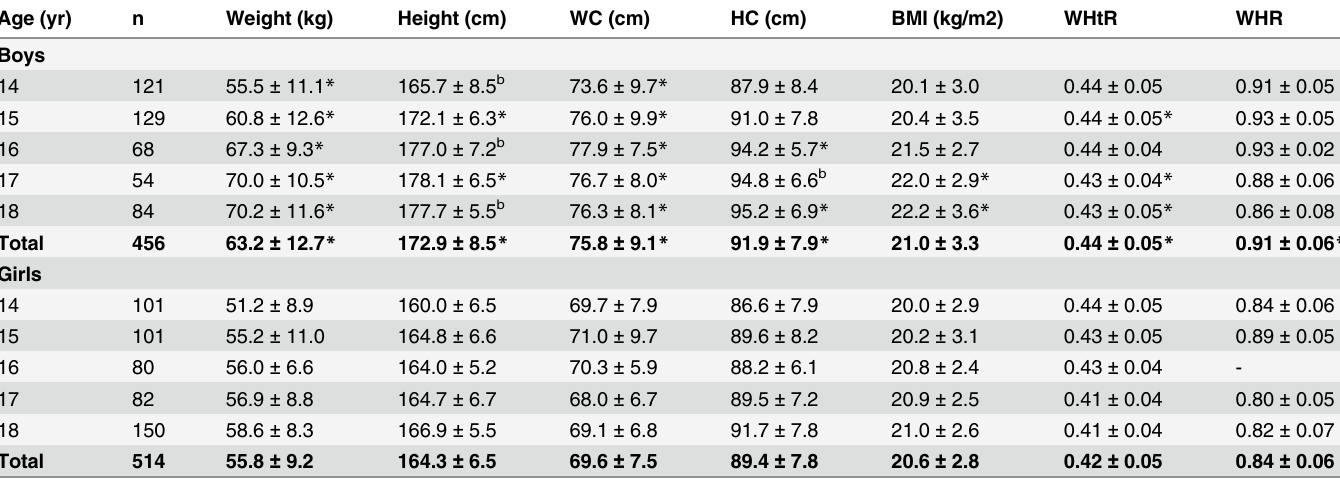
Table 1. Mean values ( ± SD) of body measurements in male and female Polish adolescents aged 14 –